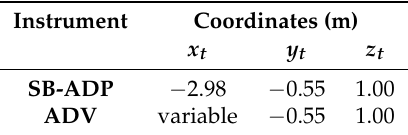
Table 1. Instruments coordinates with reference of the tank centre.